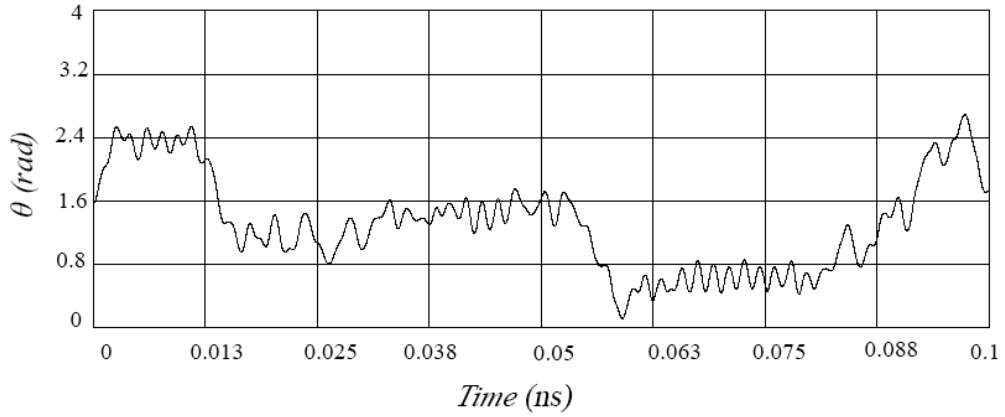
Figure 4. Angle of proper rotation of central fullerene.